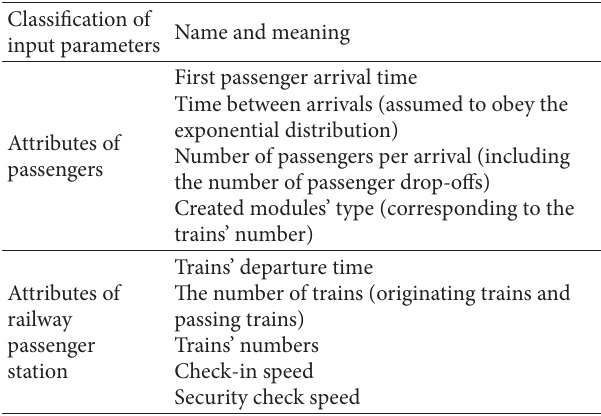
Table 3: List of input parameters used in waiting and departure